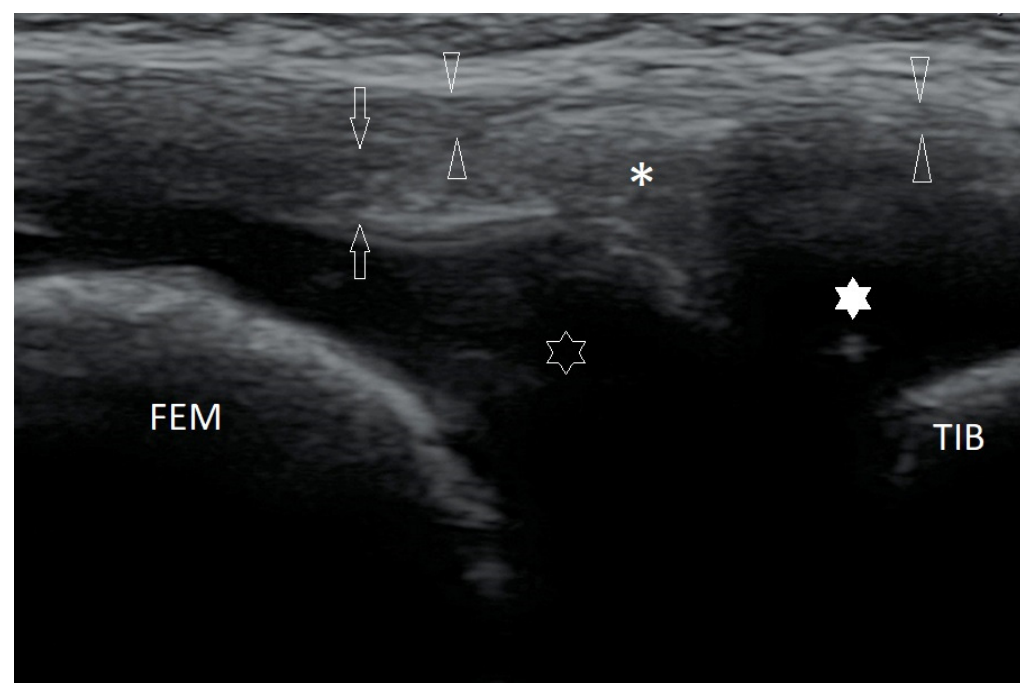
Figure 3. Longitudinal scan of the medial part of the right knee joint of a 5-year-old girl. FEM— ossified part of the medial femoral condyle (MFC); TIB—ossified part of the medial tibial condyle (MTC); hollow star—cartilaginous part of MFC; white star—cartilaginous part of MTC; asterisk— medial meniscus; arrows—deep part of medial collateral ligament (a meniscal-femoral ligament); arrowheads—the superficial (proper) part of the medial collateral ligament. Linear probe 3–12 MHz.